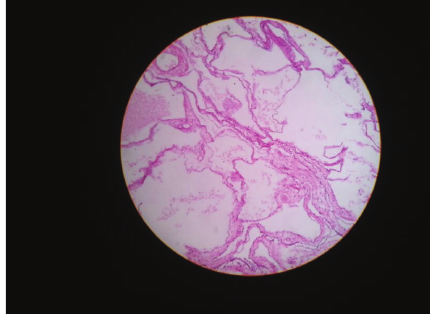
Figure 3: Microscopy showed cuboidal epithelium lined tumor filled with eosinophilic proteinaceous material. Intervening septae showed fibrosis and dense lymphoplasmacytic infiltrate admixed with eosinophils and neutrophils. Microscopic picture of BMPM.